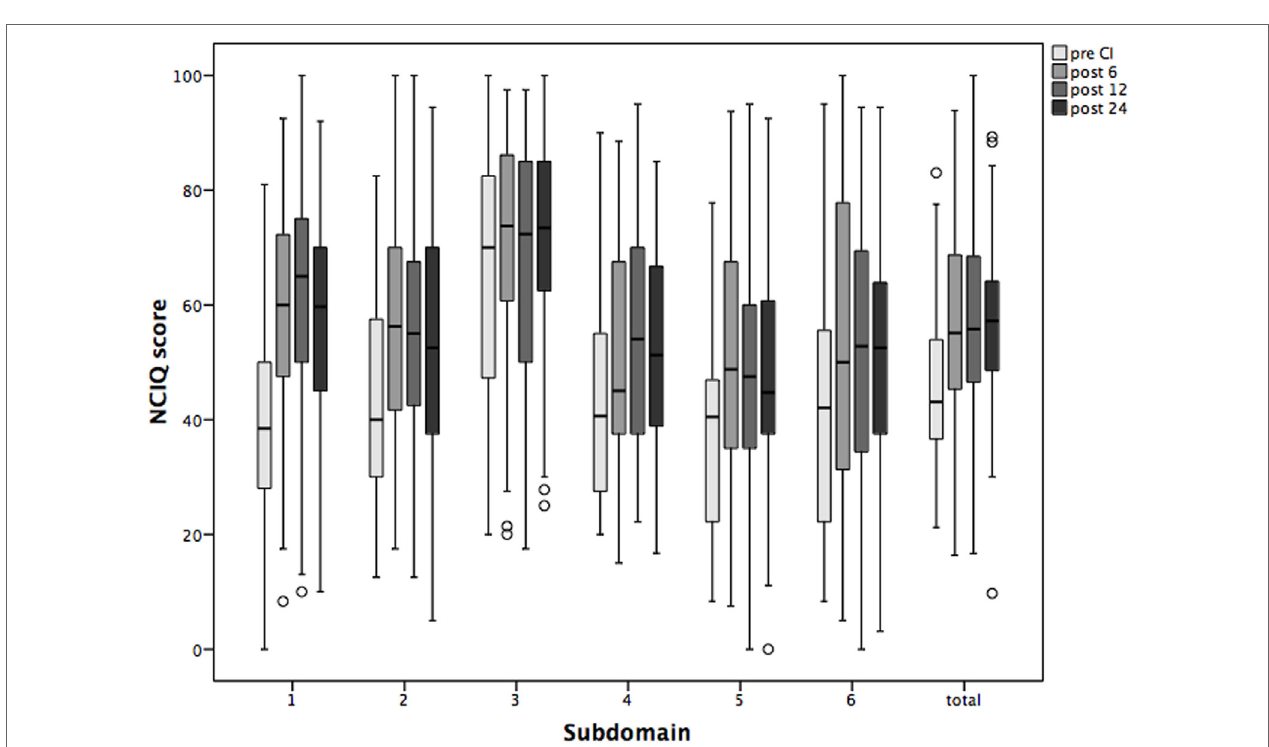
FigUre 4 | changes in the health-related quality of life nijmegen cochlear implantation Questionnaire (nciQ) and its subdomains over the period of 2 years following cochlear implantation (ci) . Shown are mean values and the 95% CI. Pre CI, before CI; post 6, post 12, and post 24, 6, 12, and 24 months after surgery. 1 basic speech perception; 2 advanced speech perception; 3 speech production; 4 self-esteem; 5 activity; and 6 social interactions.